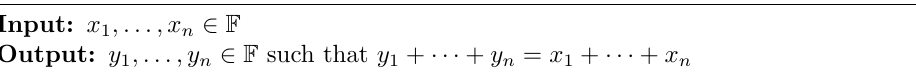
Algorithm 9 LinearRefreshMasks